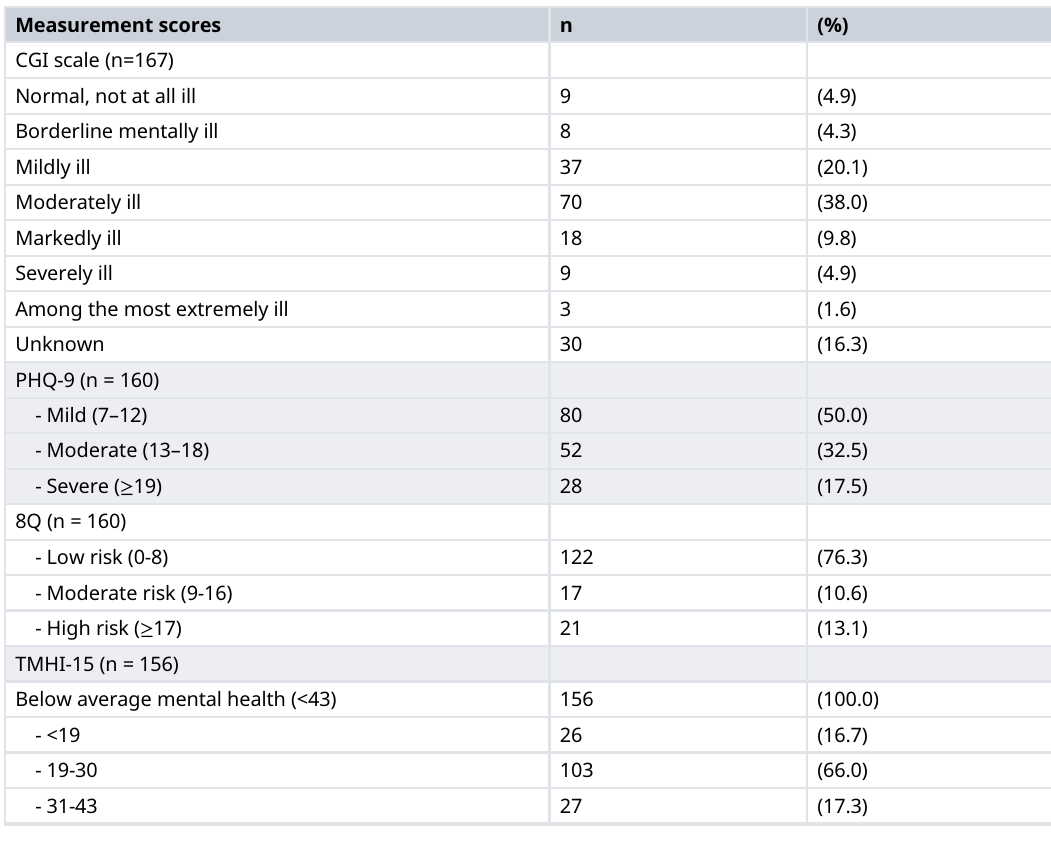
Table 3. PHQ-9, 8Q, TMH-15 and CGI scales.